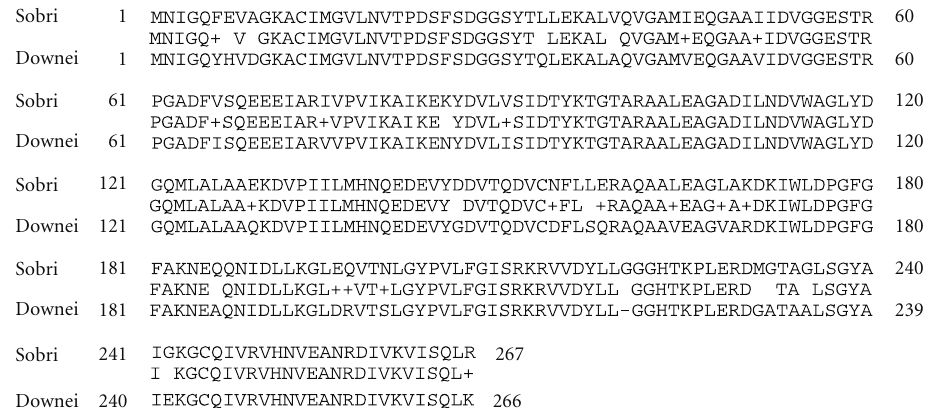
Figure 5: Comparison of DHPS amino acid sequences between Streptococcus sobrinus (Sobri) and Streptococcus downei (Downei).